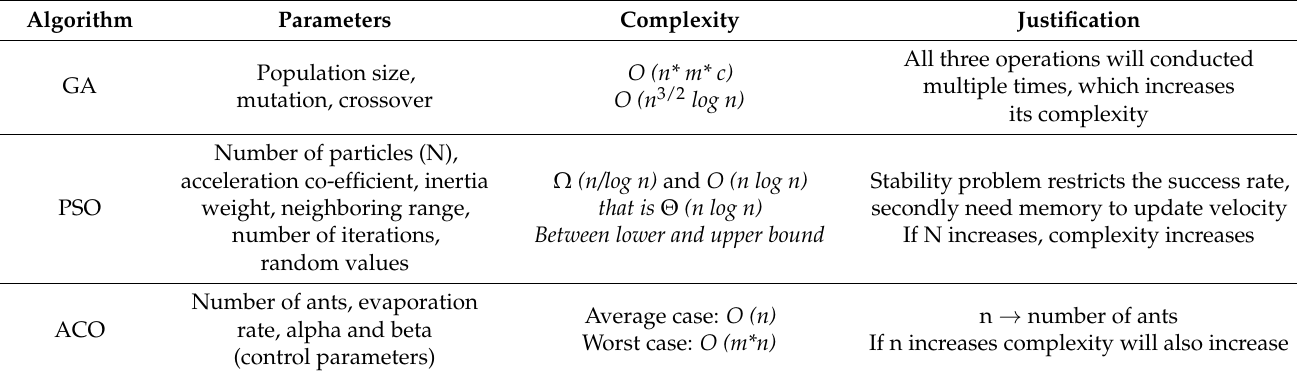
Table 2. Complexities comparison of significant